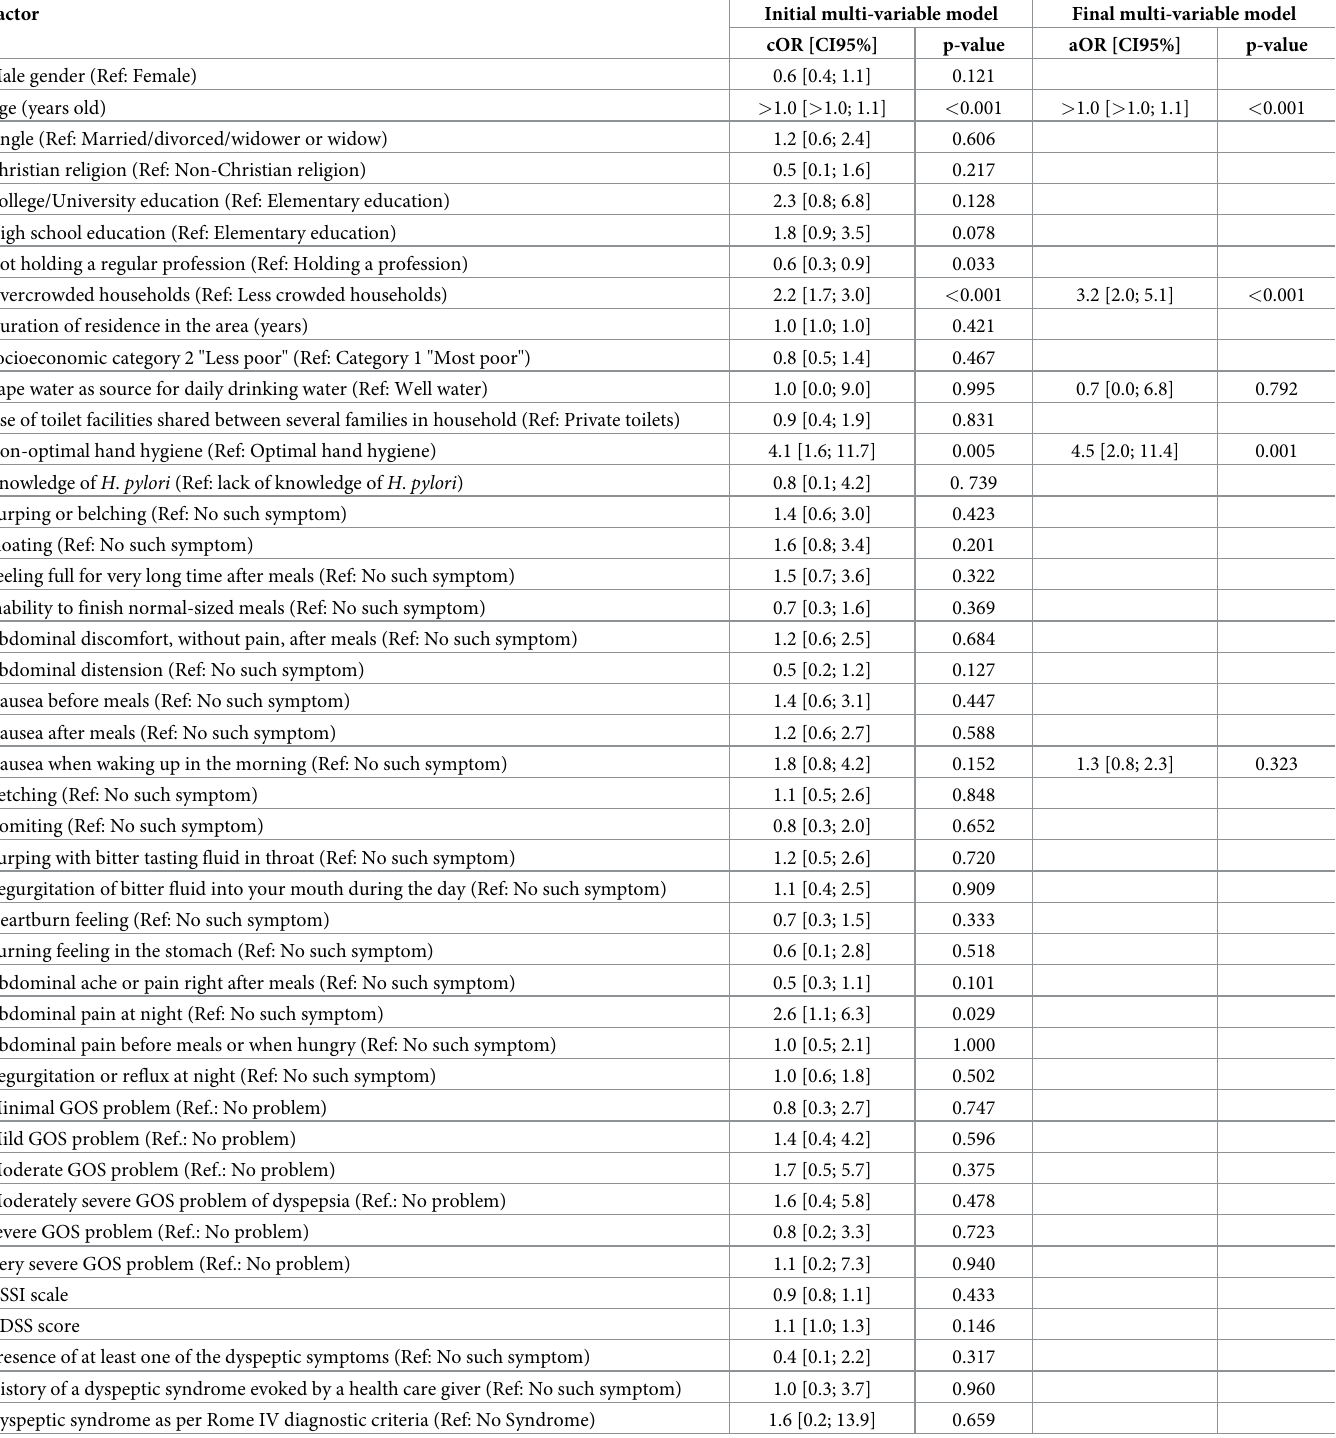
Table 8. Logistic regression models detecting factors that predict the H . pylori seropositivity in the study population � .